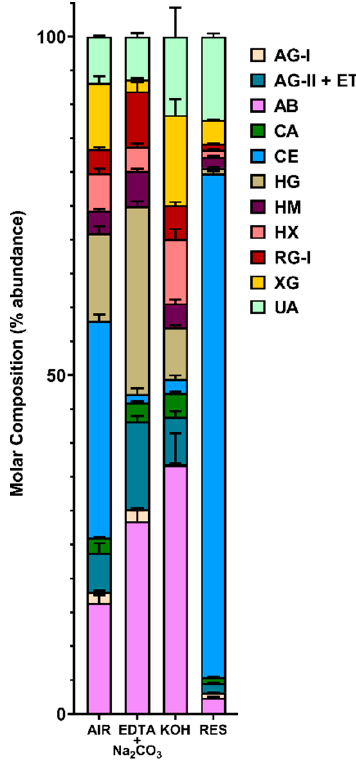
Figure 3. Estimated polysaccharide composition of cold-pressed canola meal cell wall (de-starched AIR) and its three fractions (EDTA + Na 2 CO 3 , 4 M KOH, Residue). The composition of polysaccharides was estimated based on linkage composition data (Figure 2 and Supplemental Table S1) by assigning the linkages of uronic acids and neutral sugars to polysaccharides (Table 1; as in [36]). A pre-treatment of NaBD 4 was conducted to the cell wall before its sequential fractionation in order to increase the extricability of polysaccharides. Four separate experiments conducted to cell wall and three to each fraction. Stacked bar plots are shown, with a mean value from the separate experiments represented as a horizontal bar and bars depicting the standard deviation from the mean. The polysaccharides were assigned as in Table 1: Arabinan (AB), type I arabinogalactan (AG-I), type II arabinogalactan (AG-II) and extensin (ET), heteroxylan (HX), xyloglucan (XG), callose (CA), cellulose (CE), rhamnogalacturonan I (RG-I), homogalacturonan (HG), heteromannan (HM), and unassigned linkages (UA).